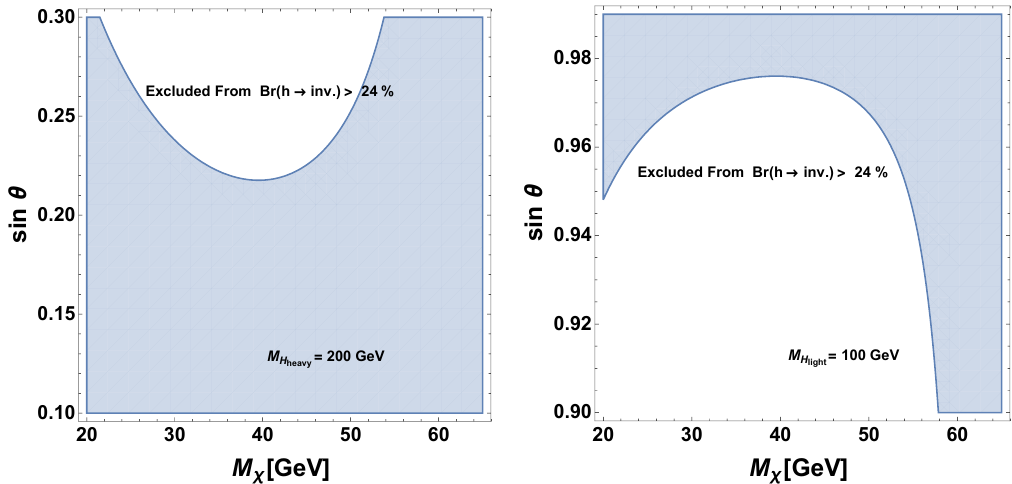
Figure 18 . Invisible Higgs decay constraint for M (cid:31) < m h sin (cid:18) and DM mass. Left panel shows the case for heavy Higgs mass region with M H Right panel shows the case of light Higgs mass with M H while the white region is